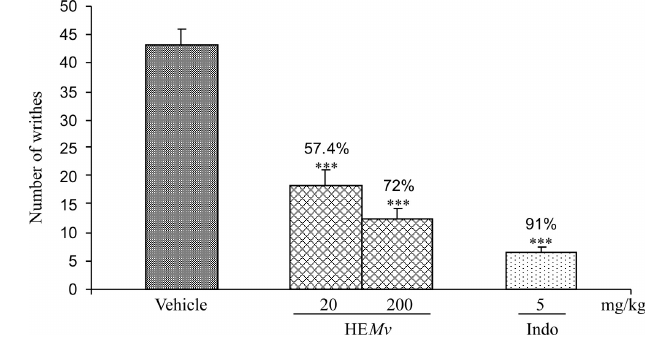
FIGURE 5 - Effect of hydroethanolic extract of M. velame on acetic acid-induced writhing in mice. Values are expressed as mean ± S.E.M. (n = 7-8). One-way ANOVA followed by Student- Newman–Keuls test. Significantly different to control, ***p<0.001.